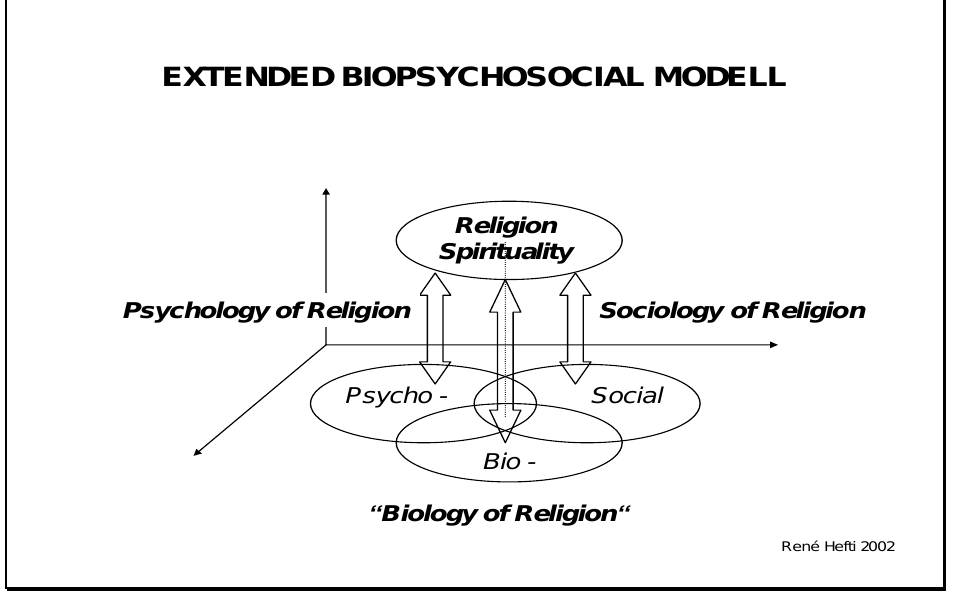
Figure 1. Extended bio-psycho-social model integrating religion/spirituality as a fourth